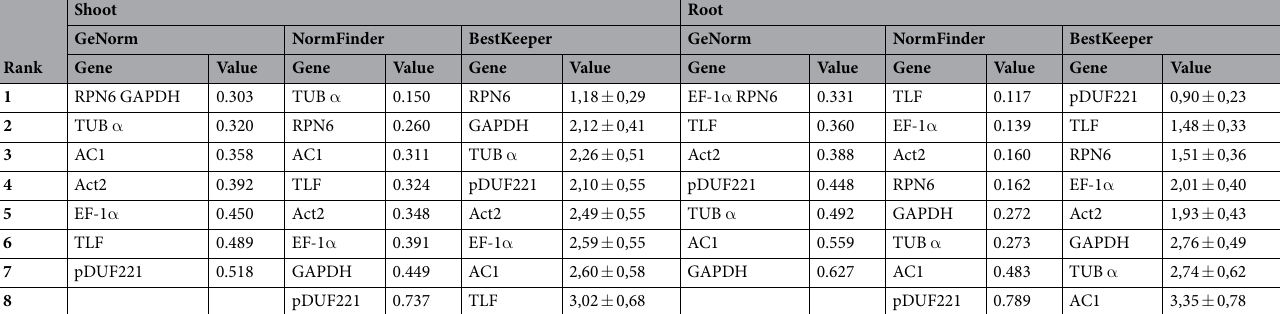
Table 4. Stability ranking of each candidate reference gene using different algorithms under heavy metal treatment in shoot and root. Column “value” corresponds to M in geNorm, S in NormFinder and CV ± SD in BestKeeper.